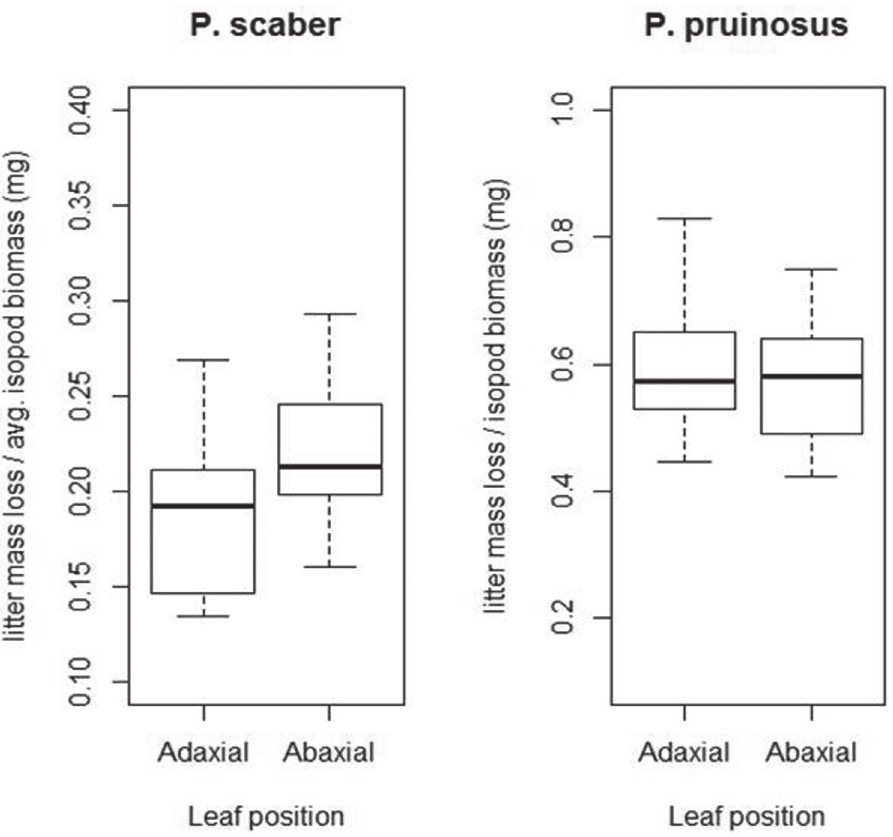
Figure 3. Effects of leaf litter positioning (abaxial up vs. abaxial down) on litter consumption of two isopod species. Note the different scaling of y axes. Legend: P. pruinosus: Porcellionides pruinosus ; P. scaber: Porcellio scaber ; Adaxial = adaxial side up; Abaxial = abaxial side up; Thick line = median; box = lower and upper quartiles; whisker = min. and max